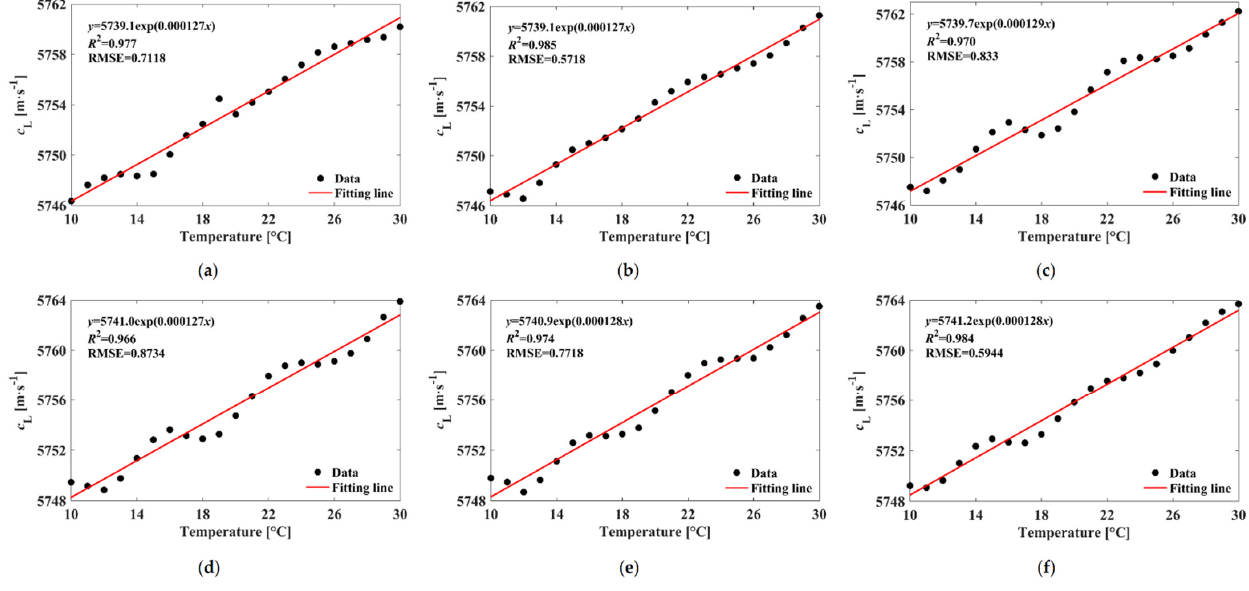
Figure 8. Changes in c L (m · s − 1 ) with temperature for all measured samples: ( a ) sample 1#; ( b ) sample 2#; ( c ) sample 3#; ( d ) sample 4#; ( e ) sample 5#; ( f ) sample 6#.